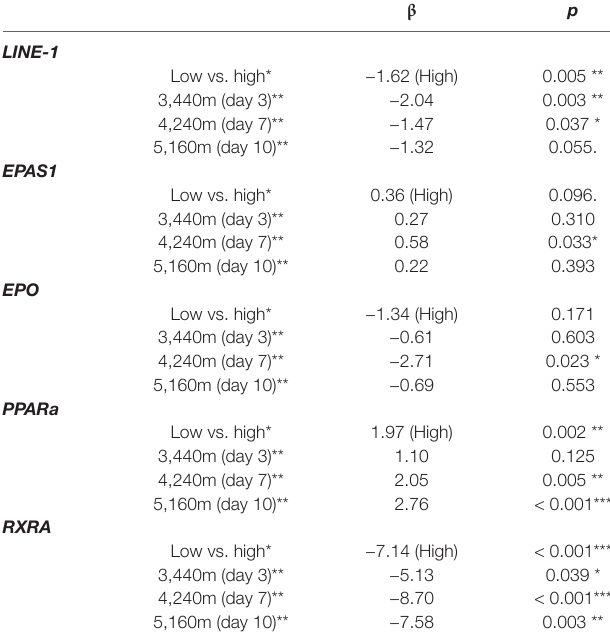
TABLe 2 | Associations between DNA methylation and